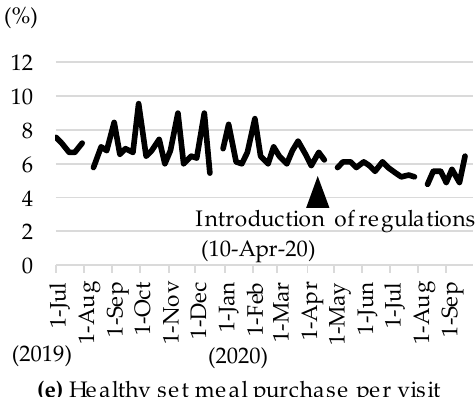
Figure 1. The number of visits to the workplace cafeteria and the purchase of dishes per cafeteria visit from 1 July 2019 to 30 September 2020. Pandemic regulations in the workplace cafeteria were implemented on 10 April 2020. ( a ) Cafeteria visit; ( b ) Grain dish (syusyoku) purchase per visit; ( c ) Main dish (syusai) purchase per visit; ( d ) Side dish (fukusai) purchase per visit; ( e ) Healthy set meal purchase per visit.